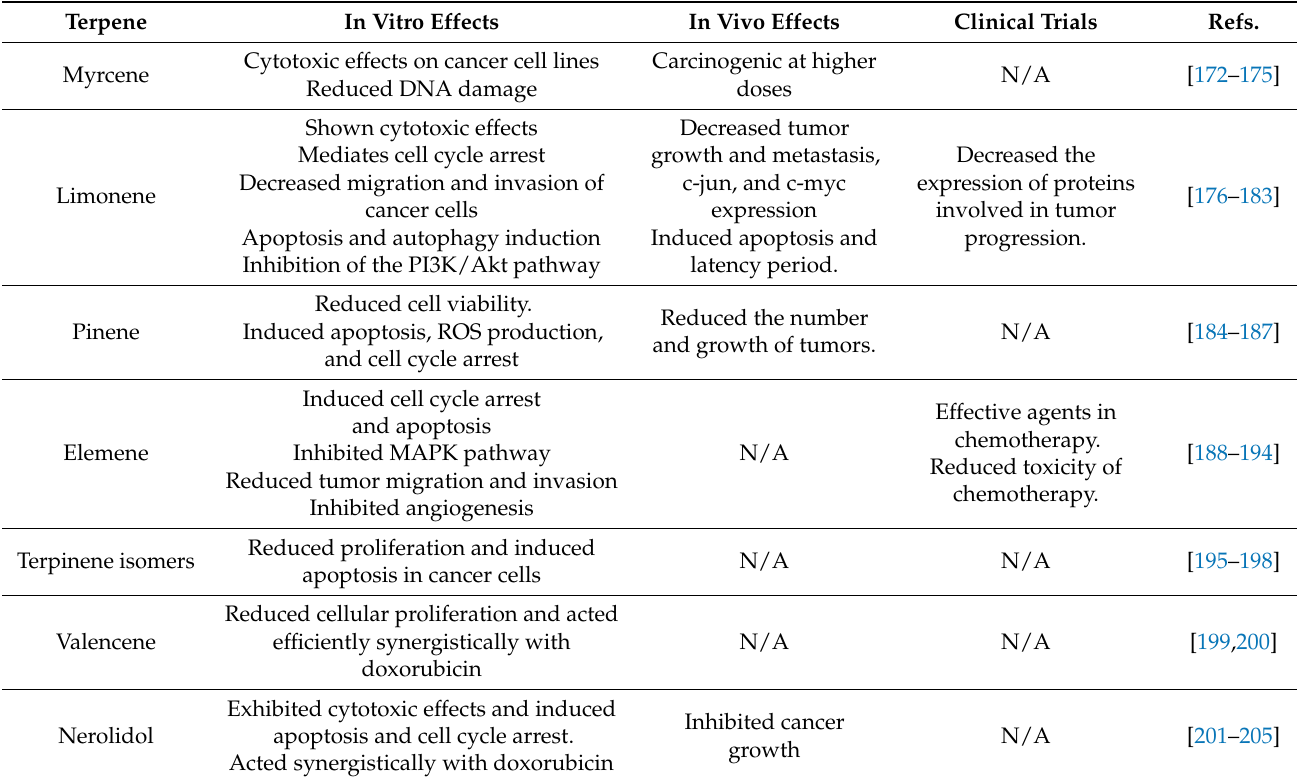
Table 4. Anti-proliferative role of terpenes in